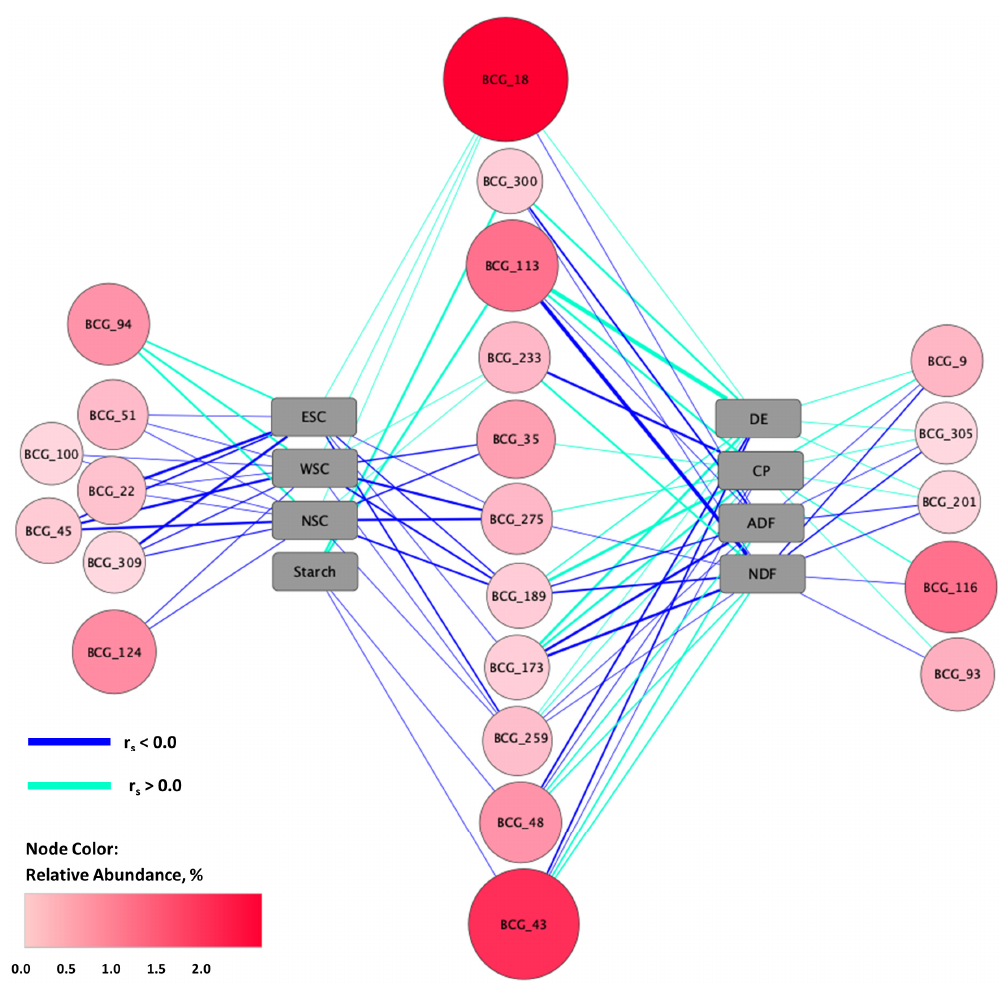
Figure 4. Network map of forage nutrients and bacterial co-abundance groups (BCG). Nutrients included digestible energy (DE), crude protein (CP) acid detergent fiber (ADF), neutral detergent fiber (NDF), non-structural carbohydrate (NSC), water-soluble carbohydrate (WSC) and ethanol-soluble carbohydrate (ESC). Correlations were evaluated between nutrient concentrations and relative abundance of BCG most predictive of forage type (based on random forest modeling of BCG composition). In addition to node color, node size was also mapped to BCG relative abundance. Line width is mapped to correlation strength, with wider lines indicating stronger correlations between nutrients and BCG. Significant Spearman correlations (r s ≥ |0.30|; p ≤ 0.05) were included in the network map.